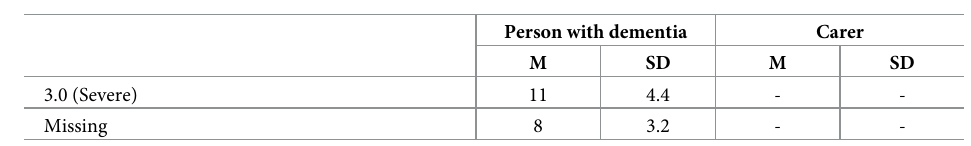
severity (p = 0.002, η p2 = 0.03) demonstrated a significant effect on C-DEMQOL scores over time.